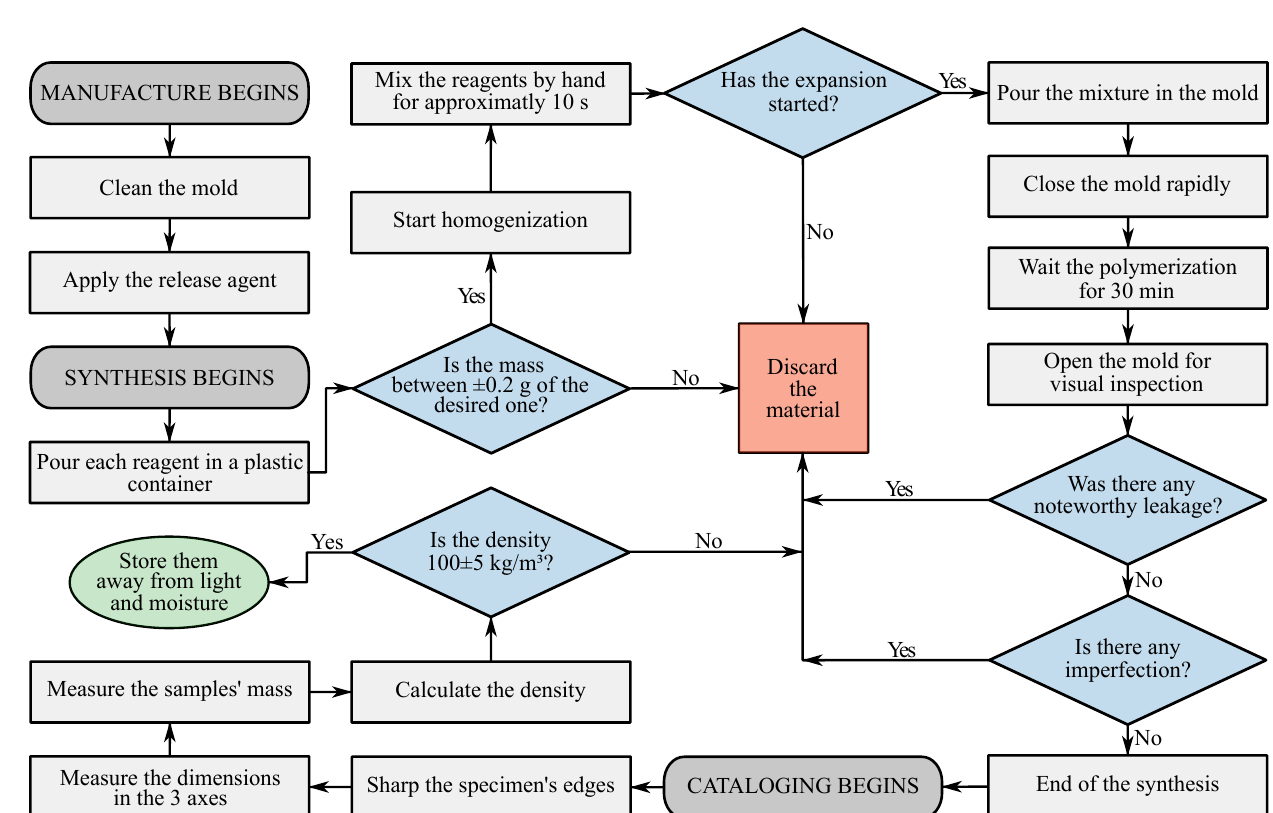
Figure 1. Flowchart of the PUF manufacturing process.